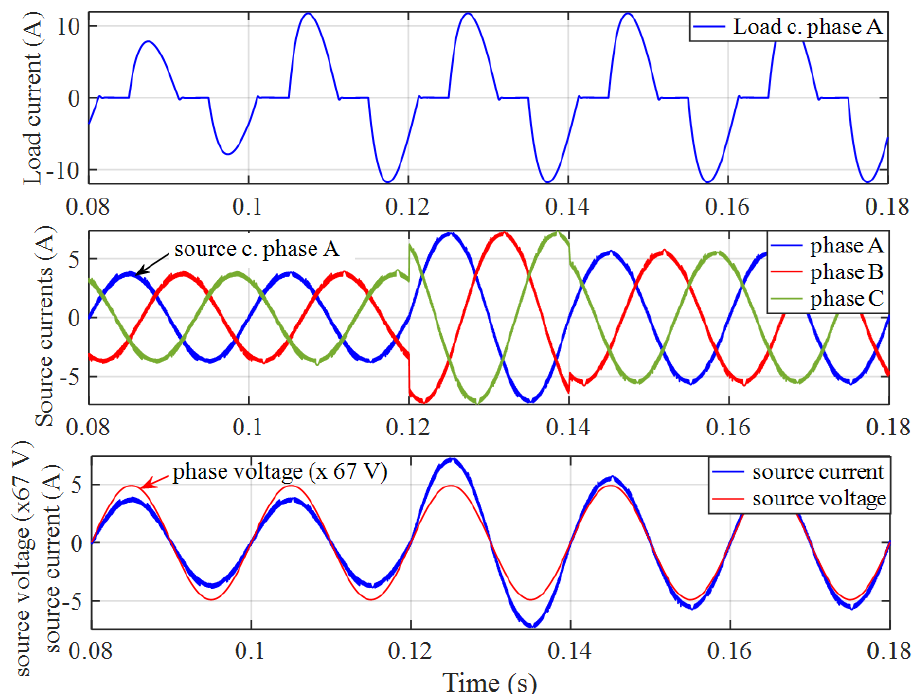
Figure 11. Dynamic response with UpfC control, applying at t = 0.1 s a load change: nonlinear load increase. Up: one phase load current. Middle: source currents, with ITHD = 3.3% after the change. Down: one phase source current and voltage, showing the PF compensation.